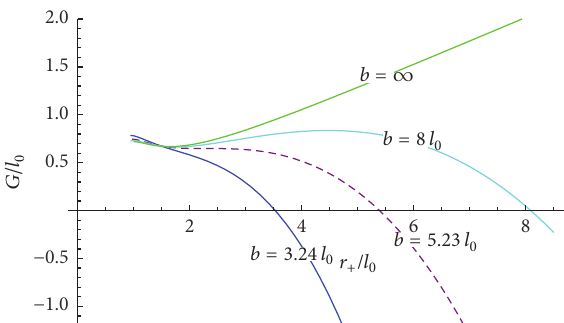
Figure 11: Plot of the Gibbs free energy 𝐺 with respect to 𝑟 + under different pressure. Particularly, thedashed purplecurvecorresponds to the case of the critical pressure. Figure 12: Sketches of